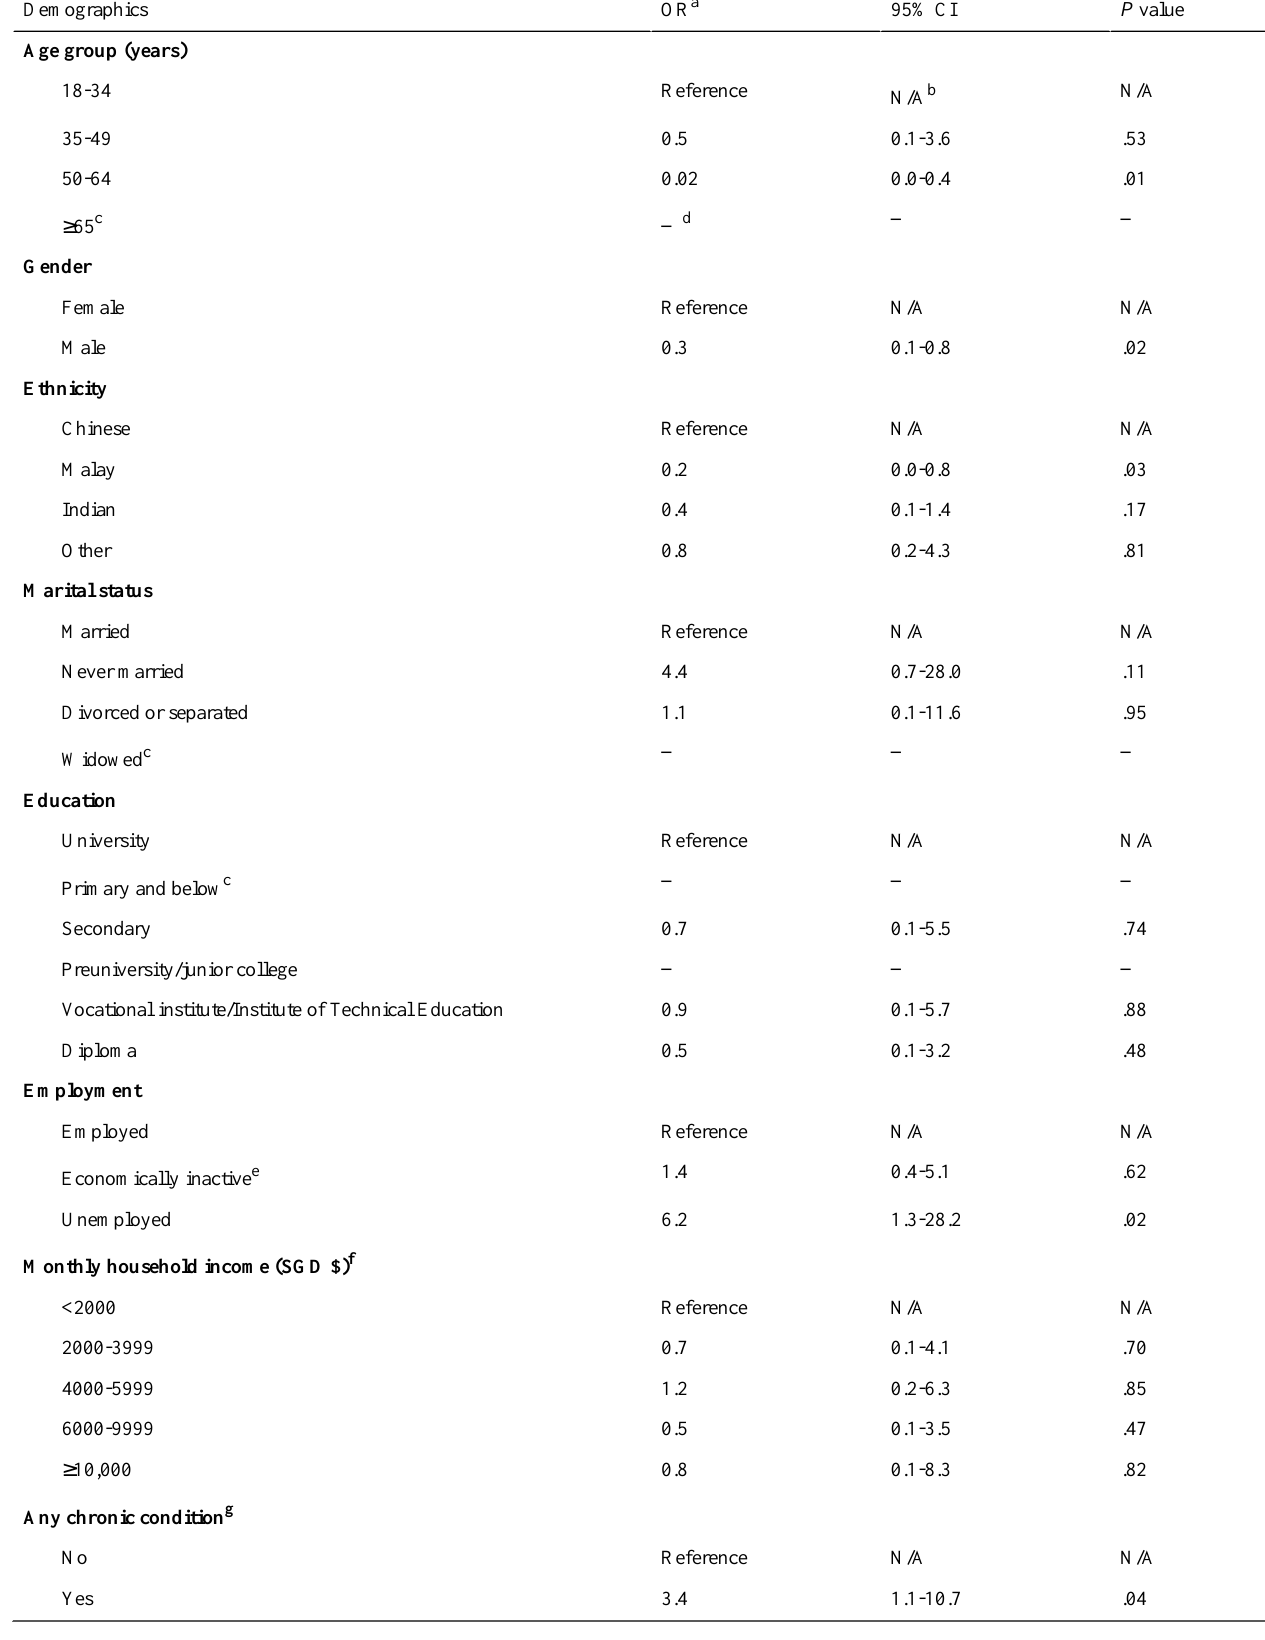
Table 3. Sociodemographic and clinical correlates of online support group use among those with any mental